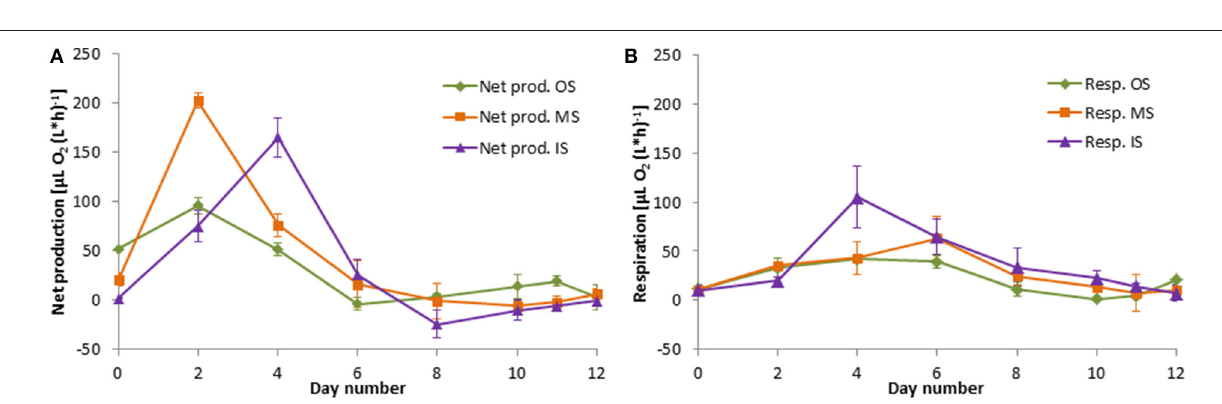
filament as well as Phaeocystis sp., Heterocapsa rotundata, and Amphidinium sp. from the filament